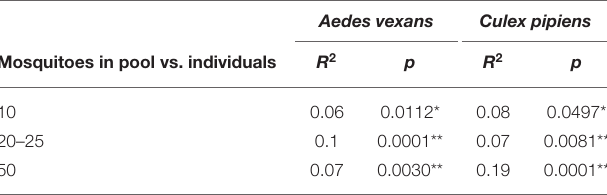
TABLE 2 | Pairwise comparisons between all pooling levels and the control (i.e., individual samples). Aedes vexans Culex pipiens Mosquitoes in pool vs. individuals R 2